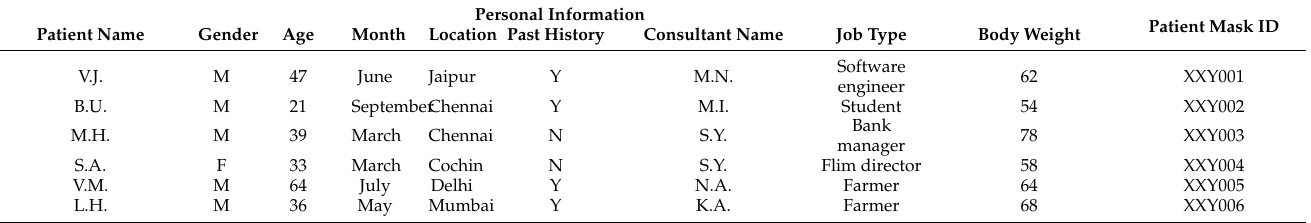
Table 1. Example data with personal information.